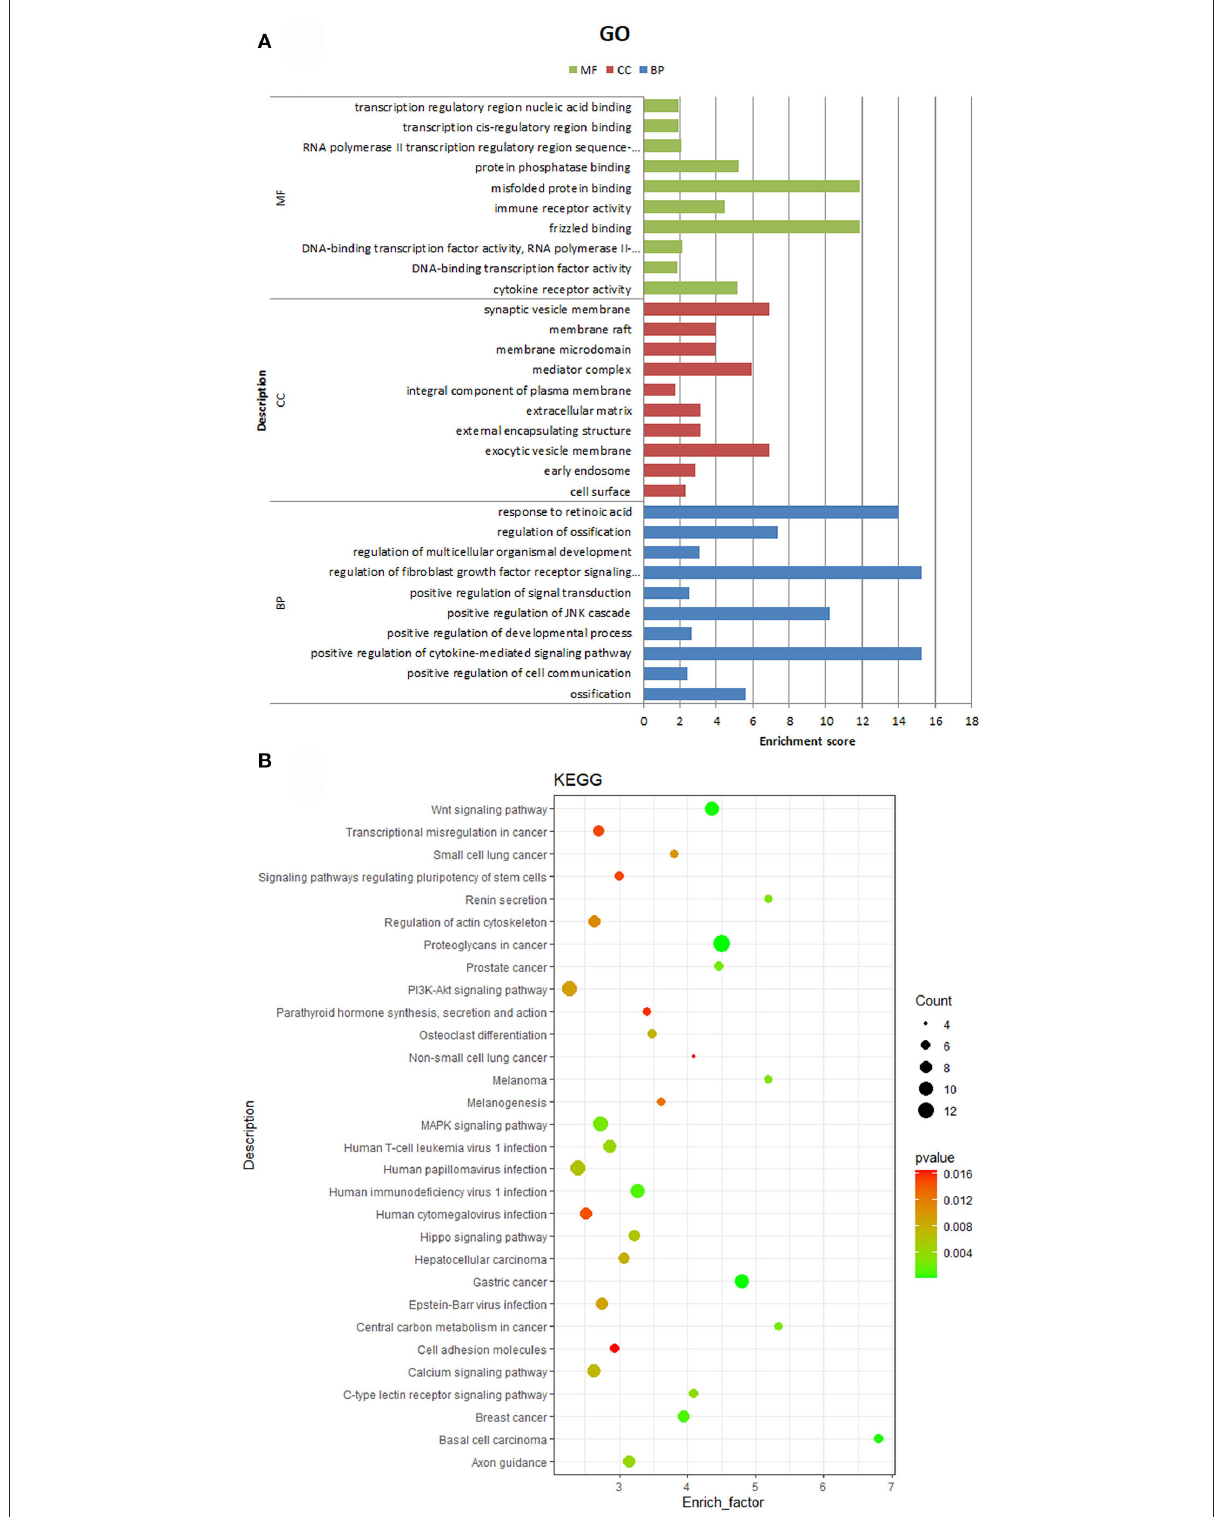
FIGURE5 (A) GO enrichment analysis of target genes. The X-axis is the enrichment factor, and the Y-axis is GO term. (B) KEGG pathway analysis of the target genes. The X-axis is the enrichment factor, and the Y-axis is KEGG